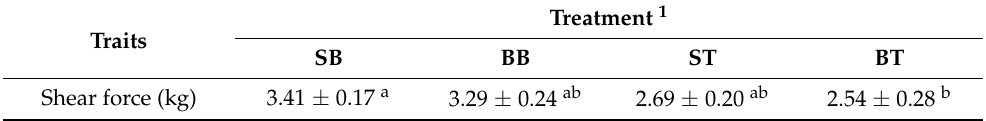
Table 2. Shear force in breast and thigh muscles from spent hens and broilers. Traits